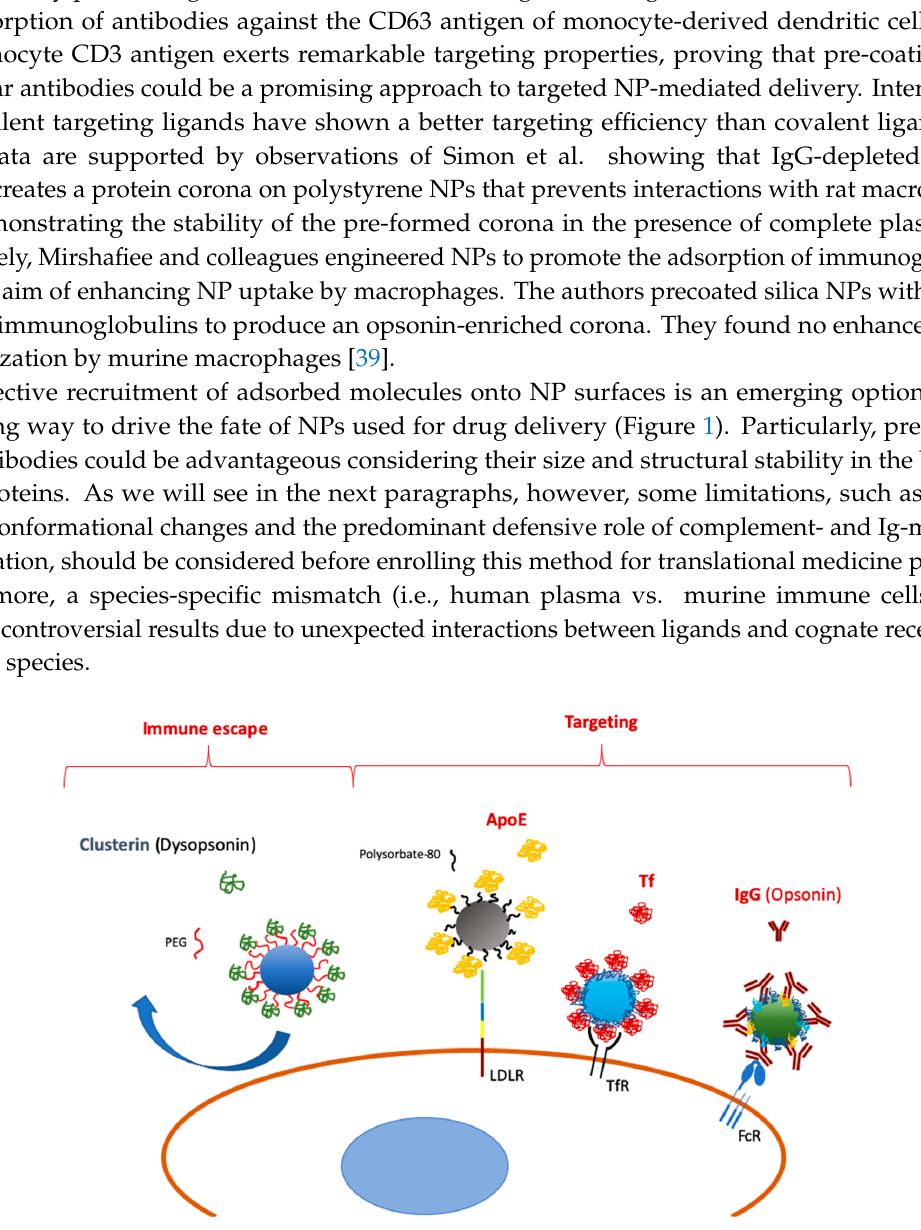
Figure 1. Scheme of selective protein adsorption onto nanoparticles (NPs) leading to immune escape and specific targeting.